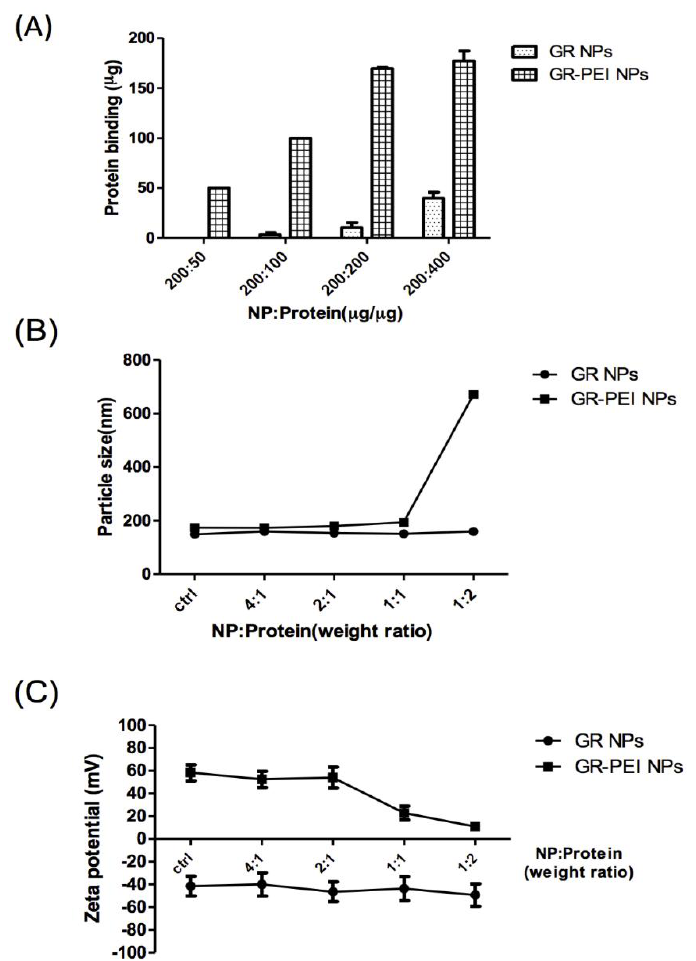
Figure 3. Protein binding efficiency of GR NPs and GR-PEI NPs. ( A ) Protein binding ability was determined with different NP:Protein ratio. ( B , C ) Different weight ratio of bovine serum albumin (BSA) was interacted with GR NPs or GR-PEI NPs for 1 h. The variation of particle size and zeta potential were measured by DLS spectroscopy. The polydispersity index (PDI) of each group was less than 0.1. The representative results are shown as M ± SD ( n = 3). Each bar represents the means of three determinations ±SD.